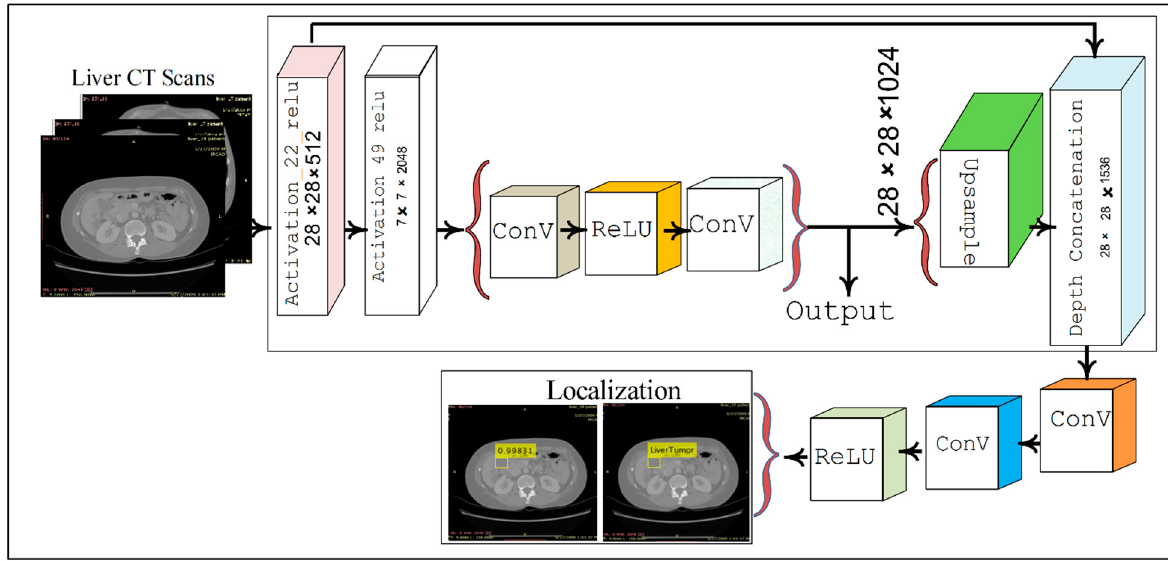
Figure 3. Proposed YOLOv3-RESNet-50 model for localization.